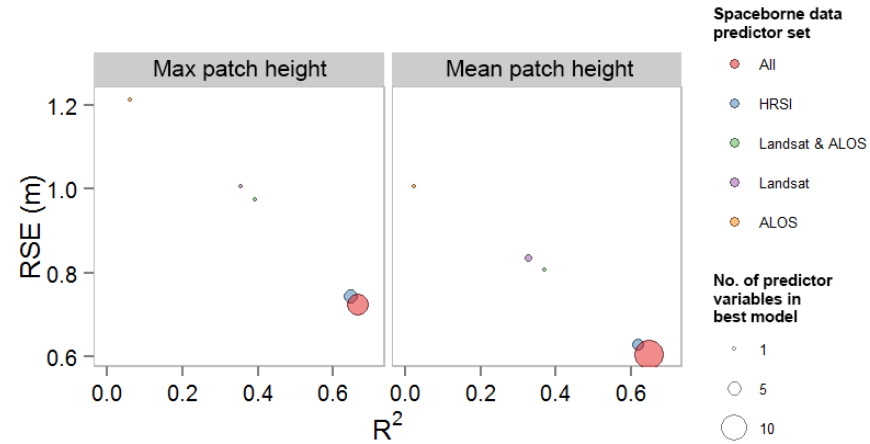
Figure 5. Results from random forest indirect forest patch height estimation for five spaceborne data predictor sets.